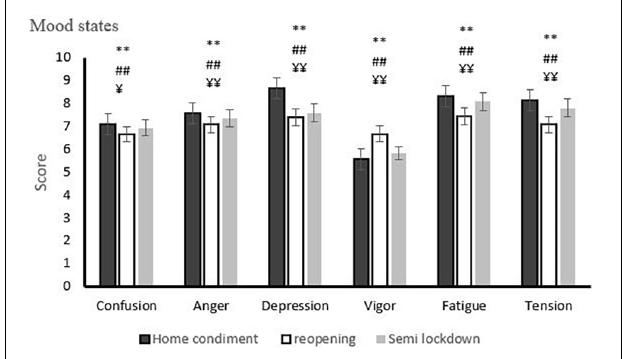
FIGURE 2 | Mood states profile during phases of home confinement, reopening, and semi-lockdown conditions. * p < 0.05 (between home confinement condition and reopening condition), ** p < 0.01 (between home confinement condition and reopening condition), # p < 0.05 (between home confinement condition and semi-lockdown condition), ## p < 0.01 (between home confinement condition and semi-lockdown condition), (cid:85) p < 0.05 (between reopening condition and semi-lockdown condition), (cid:85)(cid:85) p < 0.01 (between reopening condition and semi-lockdown condition). Each column represents the mean ratings ± S.E. (standard